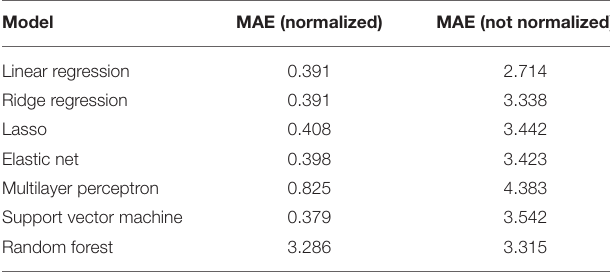
TABLE 1 | GFSI score by the